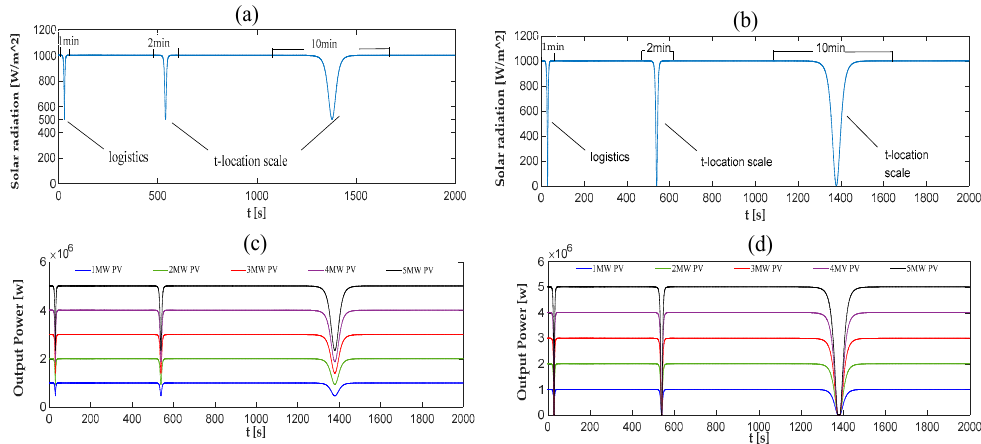
Figure 11. ( a ) 50% solar radiation fluctuation in 1-, 2-, and 10-min intervals ( b ) 100% solar radiation fluctuations in 1-, 2-, and 10-min intervals ( c , d ) active power output of PV with installed capacities of 1–5 MW.